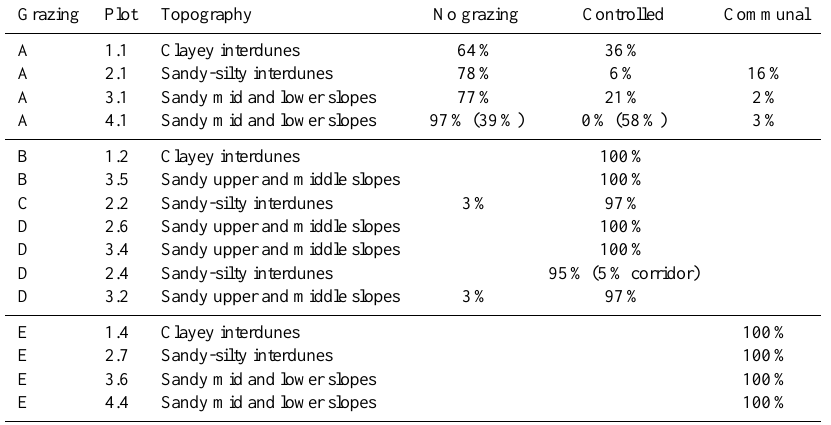
Table 1. Sampling plot characteristics and percentage coverage of differently grazed areas of coinciding MODIS pixels. Grazing: A = excluded (ungrazed), BCD = controlled, E = communal.